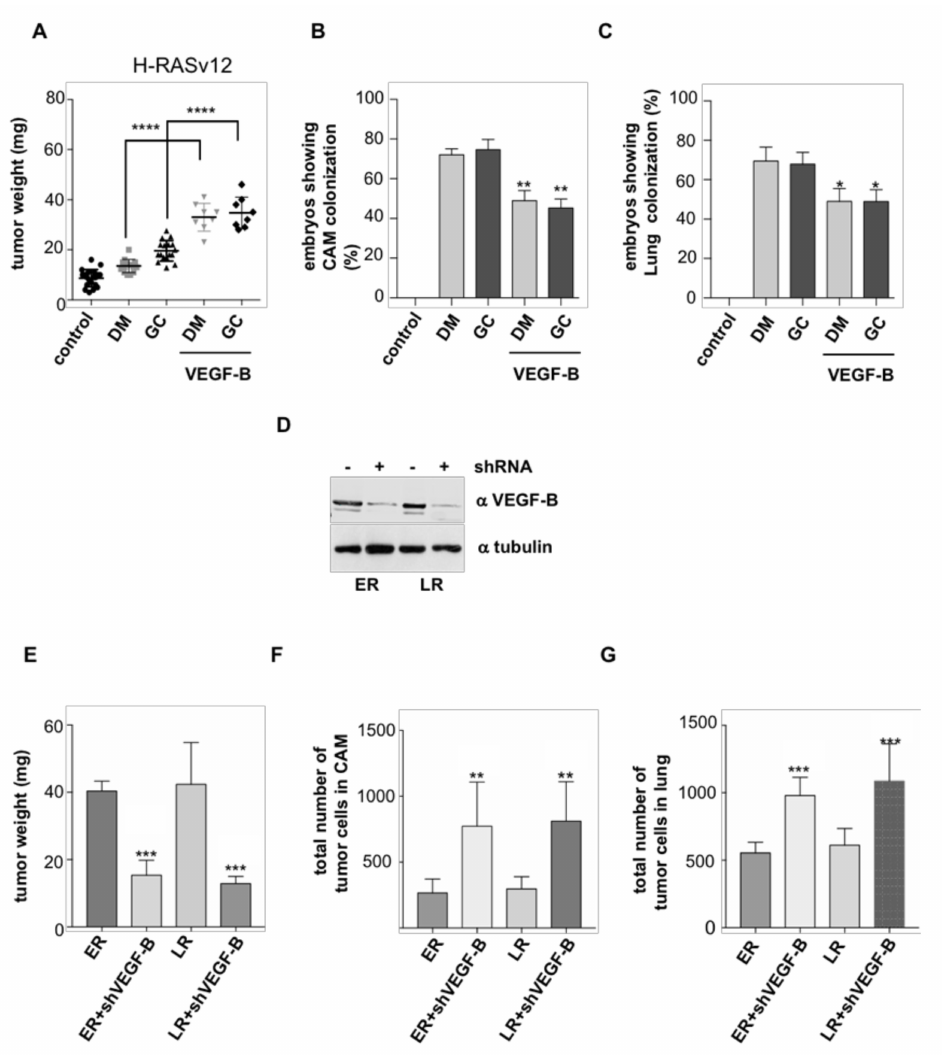
Figure 5. Changes in VEGF-B levels alter tumor behavior. Cells (10 6 ) of the indicated HRAS V12 site-specific cell lines were grafted on chick embryos. Where indicated, VEGF-B (10 nM) was added every two days beginning from day 2. After 8 days, primary tumors were collected and tissues analyzed by qPCR. ( A ) Size of the tumors. ( B ) Intravasation, expressed as the % of chicken displaying distal CAM colonization. ( C ) Distant metastases, expressed as the % of chicken displaying lung colonization. ( D ) shRNA-mediated knockdown of VEGF-B levels in PCCL3 cell lines expressing HRAS V12 at LR and ER, as indicated. ( E ) Size of the tumors, ( F ) intravasation, and ( G ) distant metastases, generated by the indicated cell lines in which VEGF-B expression has been downregulated. Data show mean ± SD ( A ); mean ± SEM ( B – E ) from three independent experiments using 5–10 embryos per case. * p < 0.05, ** p < 0.01, *** p < 0.001 and, **** p < 0.0001 by two-tailed unpaired Student t